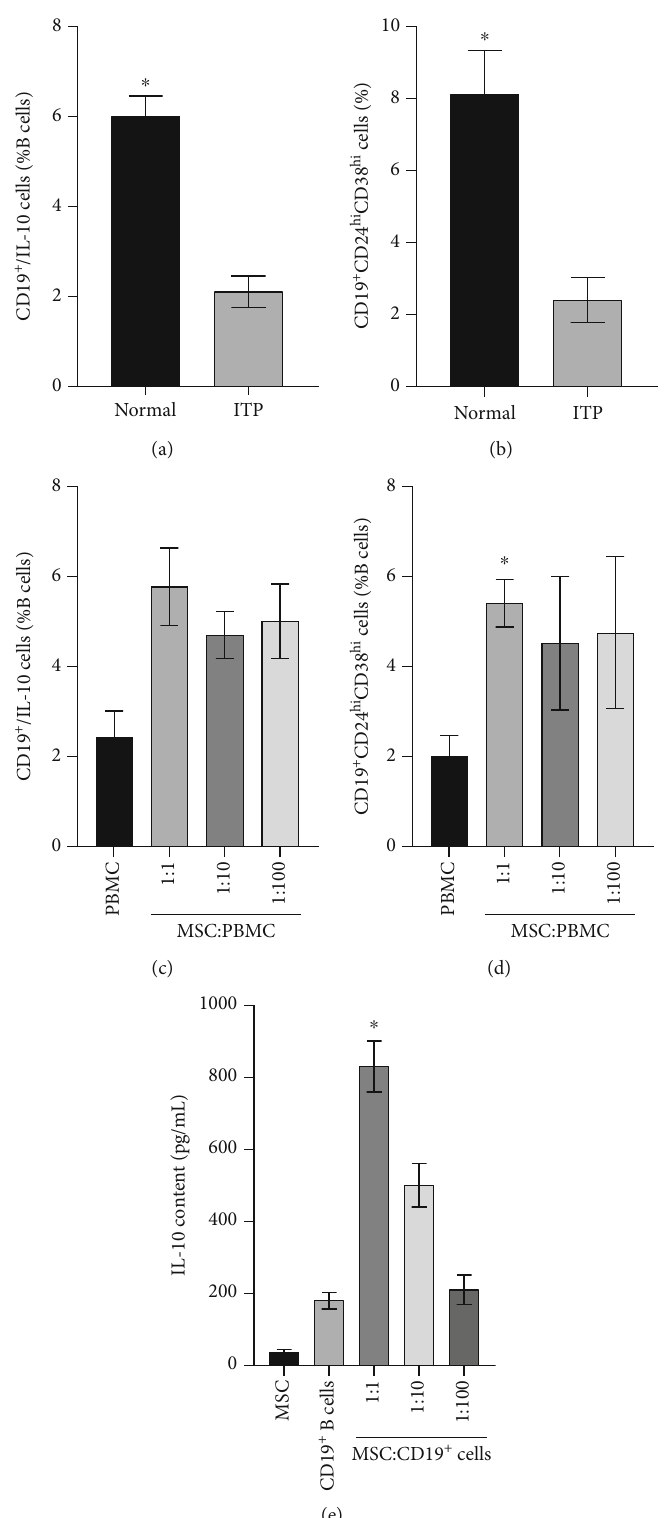
Figure 1: The e ff ects of MSCs in promoting the Breg di ff erentiation. (a) The percentages of CD19 + CD24 hi CD38 hi B cells in periphery B cells from healthy person and ITP patients. (b) The percentages of IL-10-producing CD19 + B cells in periphery B cells from healthy person and ITP patients. (c, d) Coculture MSCs with PBMCs at the ratio of 1 :1 can signi fi cantly increase the percentage of CD19 + CD24 hi CD38 hi B cells and B10 cells. (e) The concentration of IL-10 in medium promoted notably while coculture CD19 + B cells with MSC at the ratio of 1 :1. ∗ P < 0 : 05